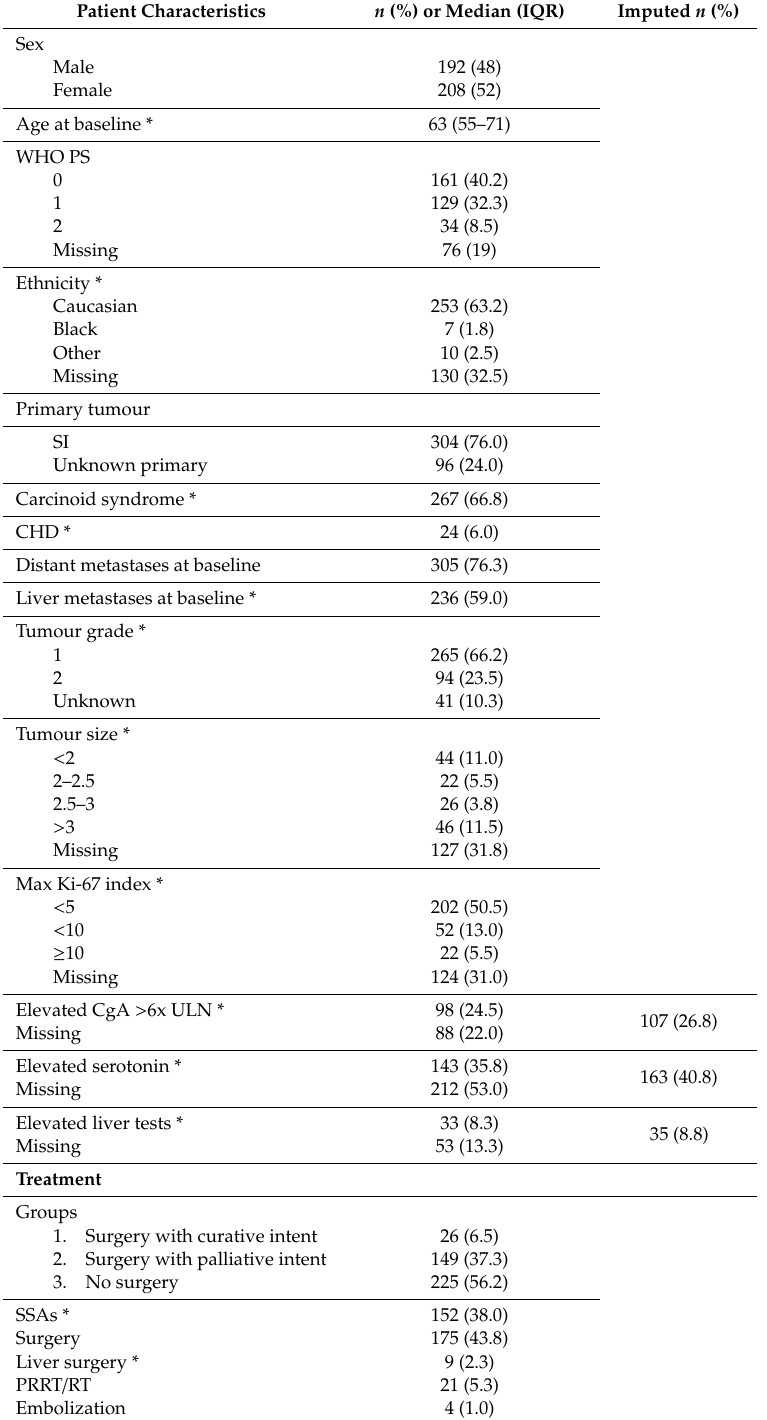
Table 1. Baseline characteristics for the institutional cohort and imputed